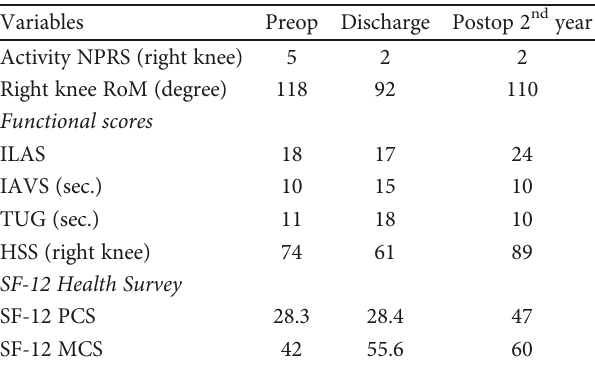
Figure 2: (a) X-ray and preoperative images of insert dislocation. (b) Postoperative 2nd year AP lateral standing. Table 1: Clinical characteristic of the patient preoperatively, at discharge, and postoperative 2nd